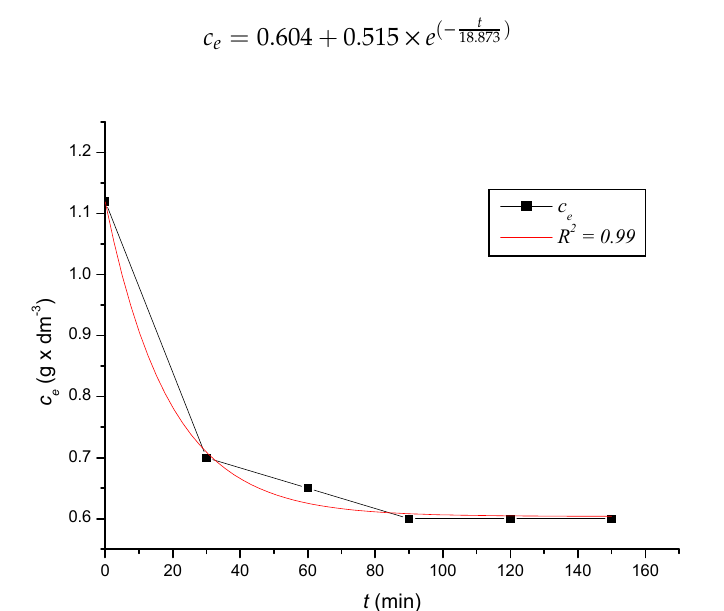
Figure 5. The kinetic course of reducing the concentration of Fe 3+ cations in a solution with an initial concentration of 1.12 g × dm −3 by the action of clinoptilolite.